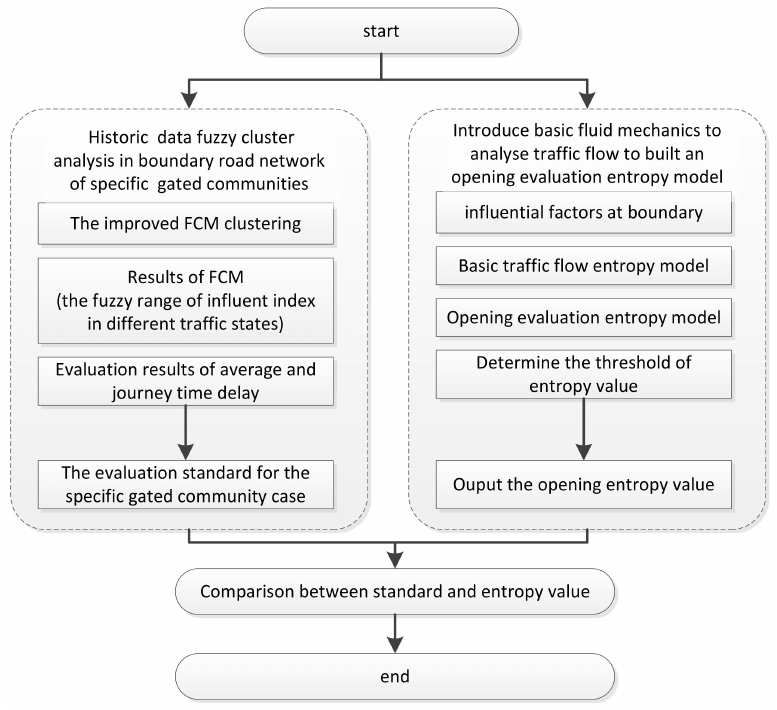
Figure 1. The framework and process of the comprehensive opening evaluation